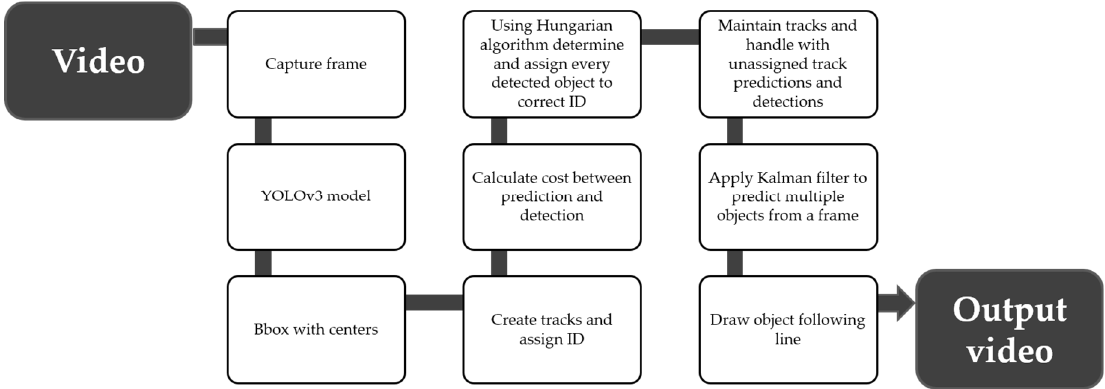
Figure 5. Detecting and tracking pipeline. YOLOv3: you only live once version 3.